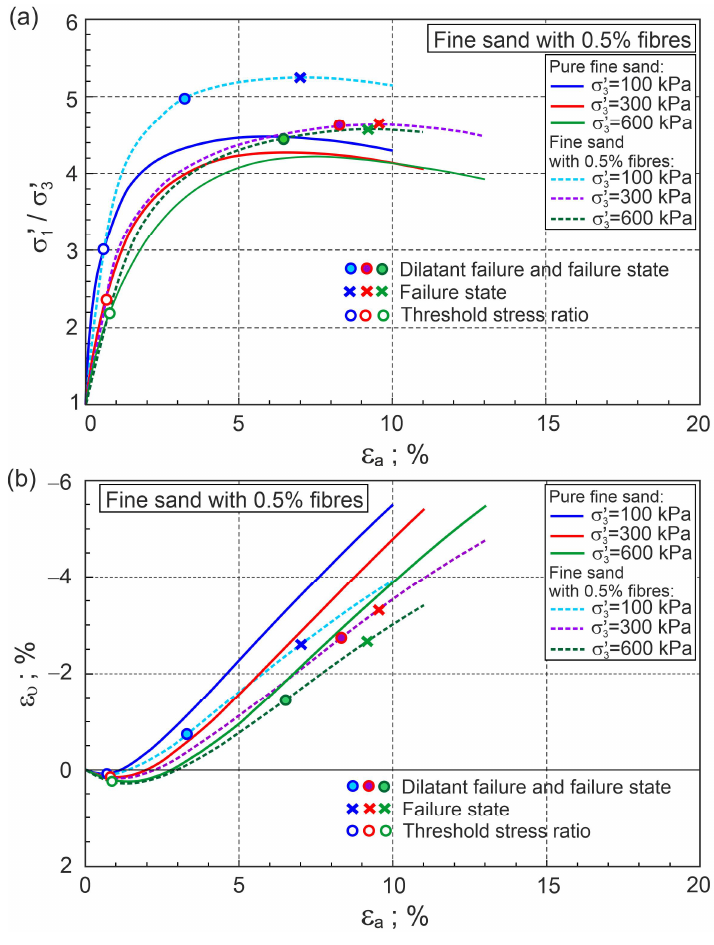
Figure 4. Relationships for fine sand with 0.5% fibres: ( a ) (cid:2026) (cid:2869)(cid:4593) (cid:2026) (cid:2871)(cid:4593) ⁄ − (cid:2013) (cid:3028) and ( b ) (cid:2013) (cid:3100) − (cid:2013) (cid:3028) (experimental data from [5]).